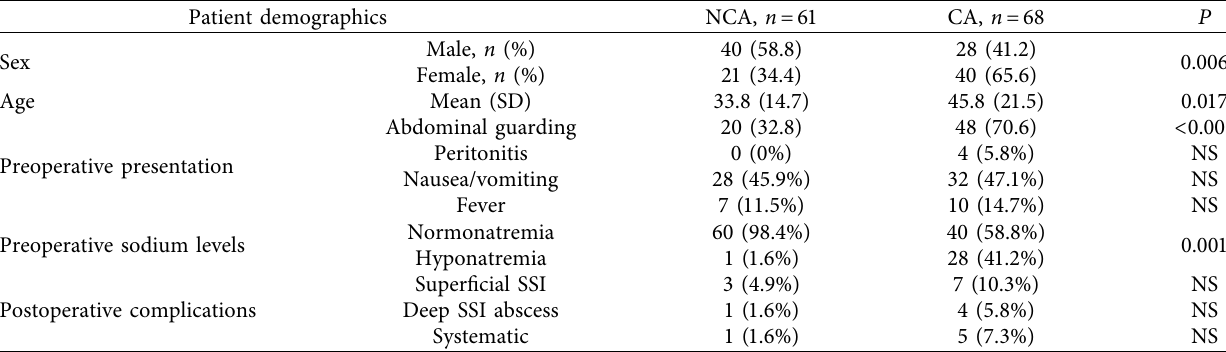
Table 1: Patient classification in noncomplicated appendicitis and complicated appendicitis according to sex (Pearson’s x 2 test), age (Student’s t -test), preoperative presentation (abdominal guarding, nausea/vomiting, and fever—Pearson’s x 2 test and peritonitis—Fisher’s exact test), postoperative complications (superficial SSI, deep SSI, and systematic—Fisher’s exact test), and preoperative sodium levels (Fischer’s exact test).